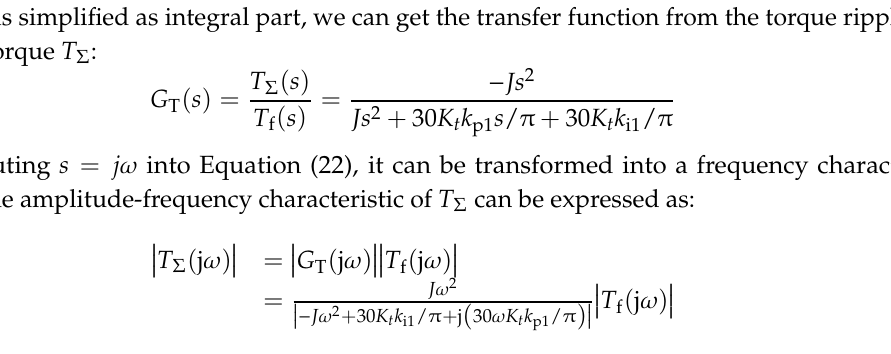
Figure 7. When   1 Q z  and different resonance frequencies.